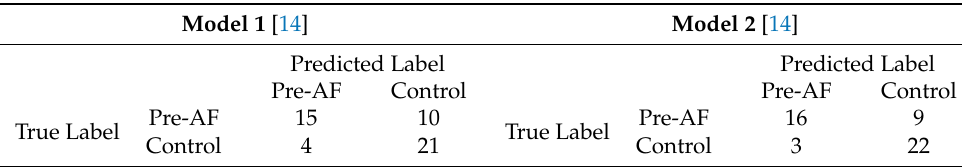
Table 4. Test results of the compared